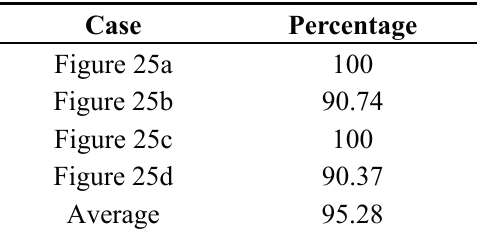
Table 2. The percentage of correctly labeled image of genuine SR versus total number of image in the four cases (Figure 25a–d, unit: